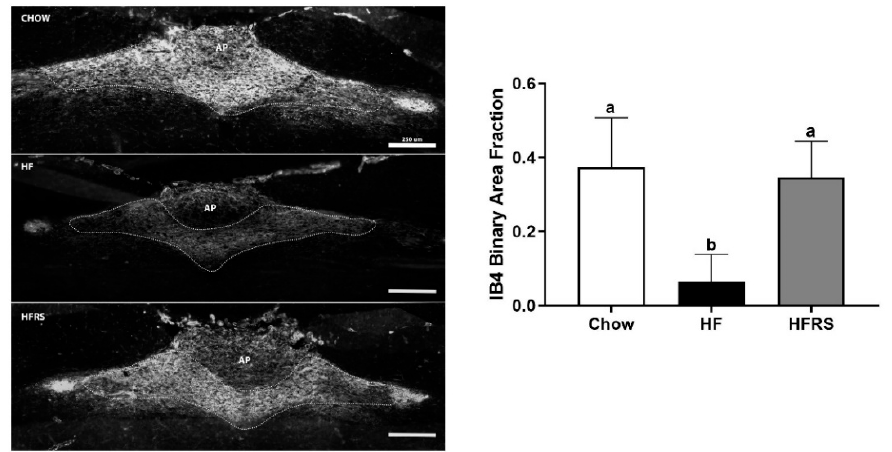
Figure 7. Potato RS prevented vagal remodeling. Representative NTS sections showing IB4 in chow, HF, and HFRS animals; the medial NTS at the level of the area postrema is outlined in white dashes ( right ), positive staining was quantified in the marked area ( left ). NTS = nucleus tractus solitarius, IB4 = isolectin B4, HF = high fat, HFRS = high-fat resistant starch. Data are presented as the mean ± SEM; a, b, c different letters indicate statically significant ( p < 0.05) differences among groups, n = 8. Scale bar = 250 µm.